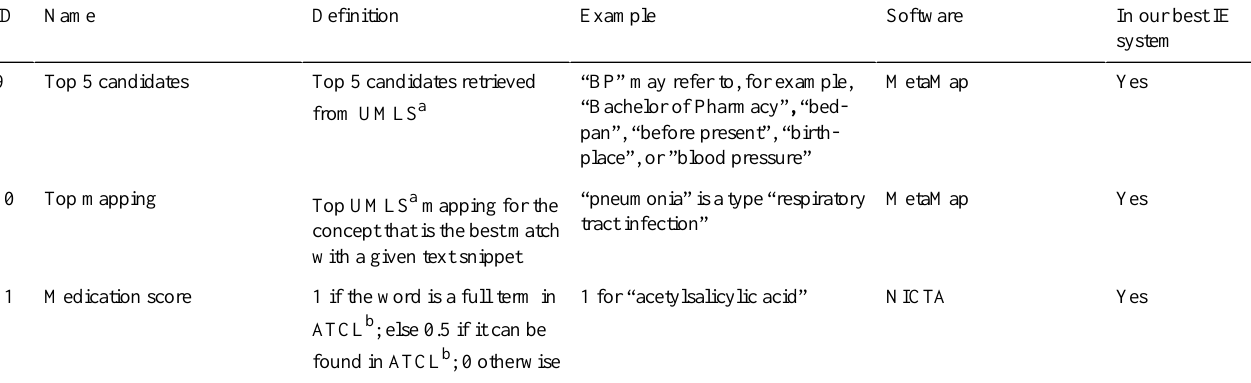
Table 2. Experimented semantic